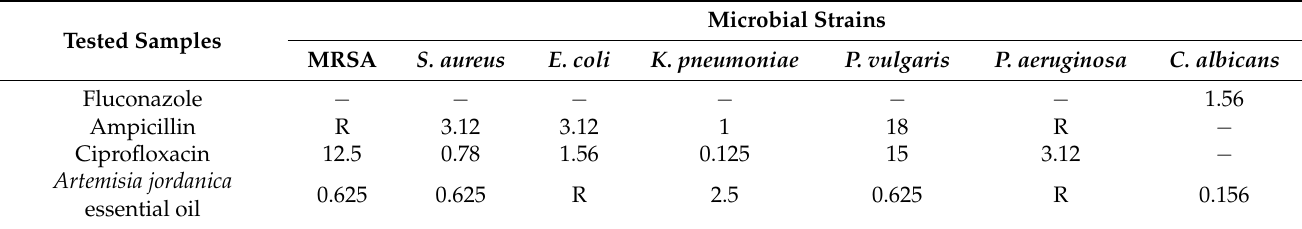
Table 3. MIC values (µg/mL) of Artemisia jordanica essential oil, ampicillin, ciprofloxacin and fluconazole. Tested Samples